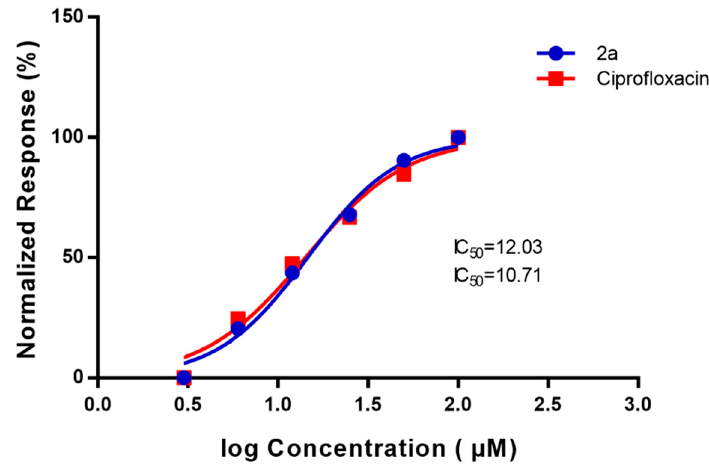
Figure 5. Dose-response inhibition curve for E. coli DNA gyrase-dependent supercoiling activity in the presence of cyclic diphenylphosphonate 2a , ciprofloxacin with different concentrations of inhibitor ( 2a ), and ciprofloxacin (standard) which showed 50% inhibition after 30 min as affecting DNA gyrase enzyme and the DNA was separated on a 1.0% ( w / v ) agarose gel. The fluorescence intensity of the supercoiled DNA band was normalized to the DMSO solvent control.